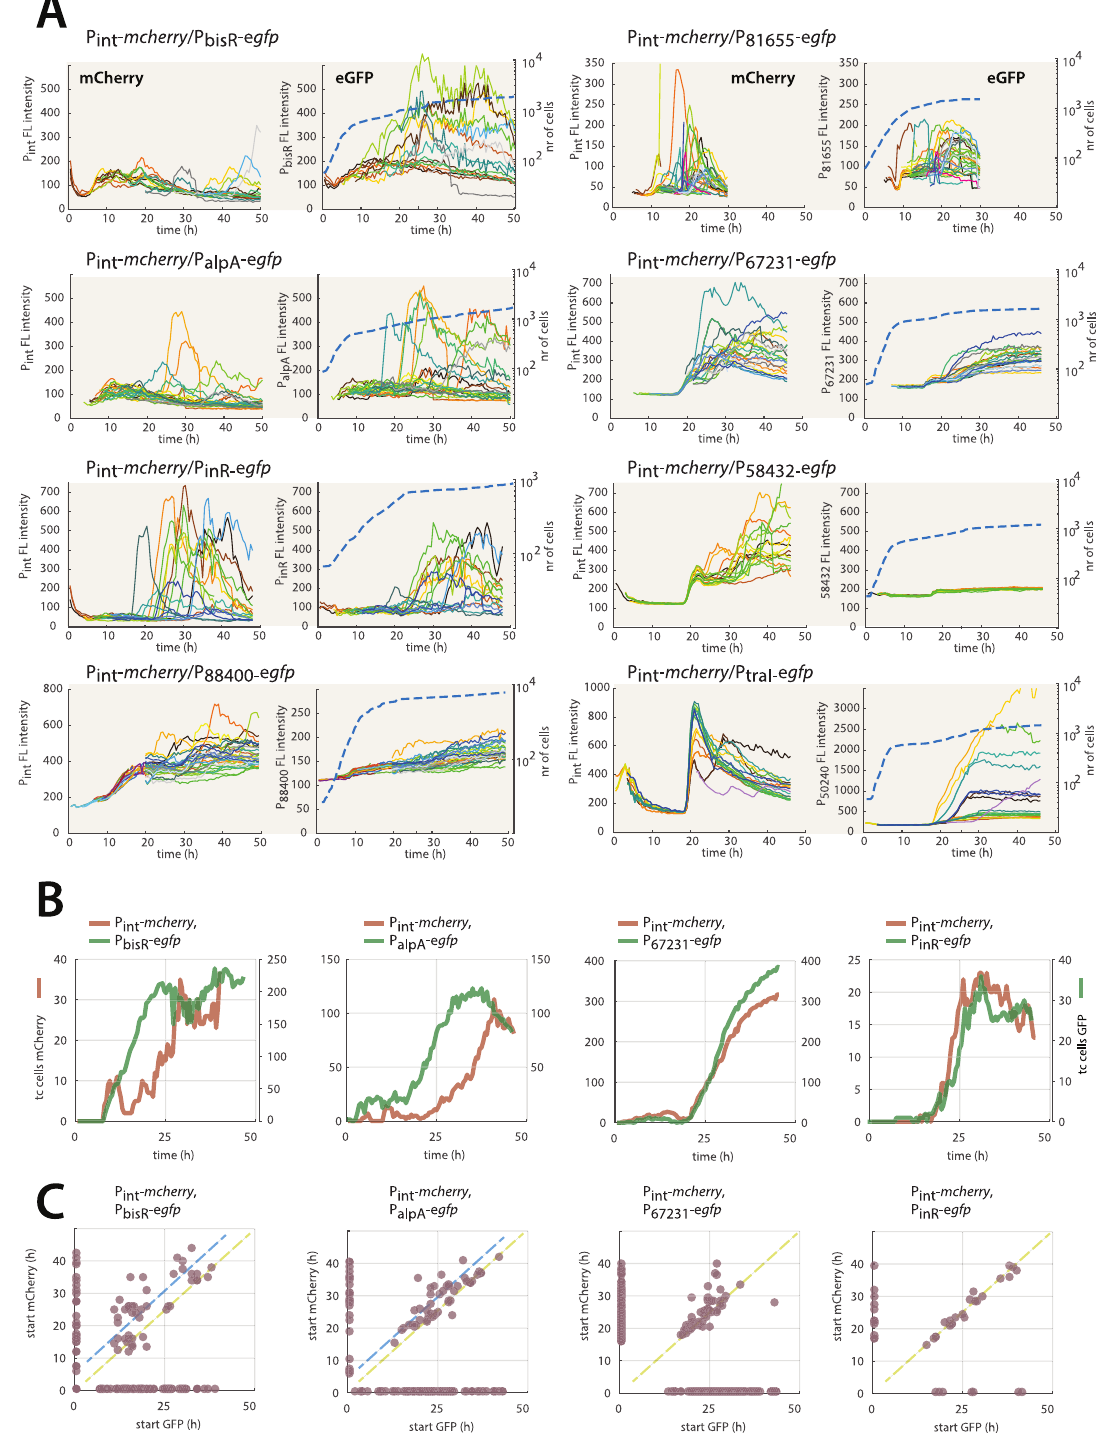
Fig 5. Temporal expression of paired promoters from the ICE clc transfer competence regulon. A Time-lapse fluorescence of selected identified tc cells of surface-grown P . knackmussii B13 with indicated single-copy inserted promoter-fluorescent reporter constructs; each line corresponding to an individual cell traced over time with corresponding colors between fluorescence channels. Thick blue dashed line indicates population growth (scale on the right) for the analyzed shown image area. Fluorescence values shown here as direct camera greyscale output, averaged over each individual cell area. The P int -P 88400 pair was manually stitched at t = 19